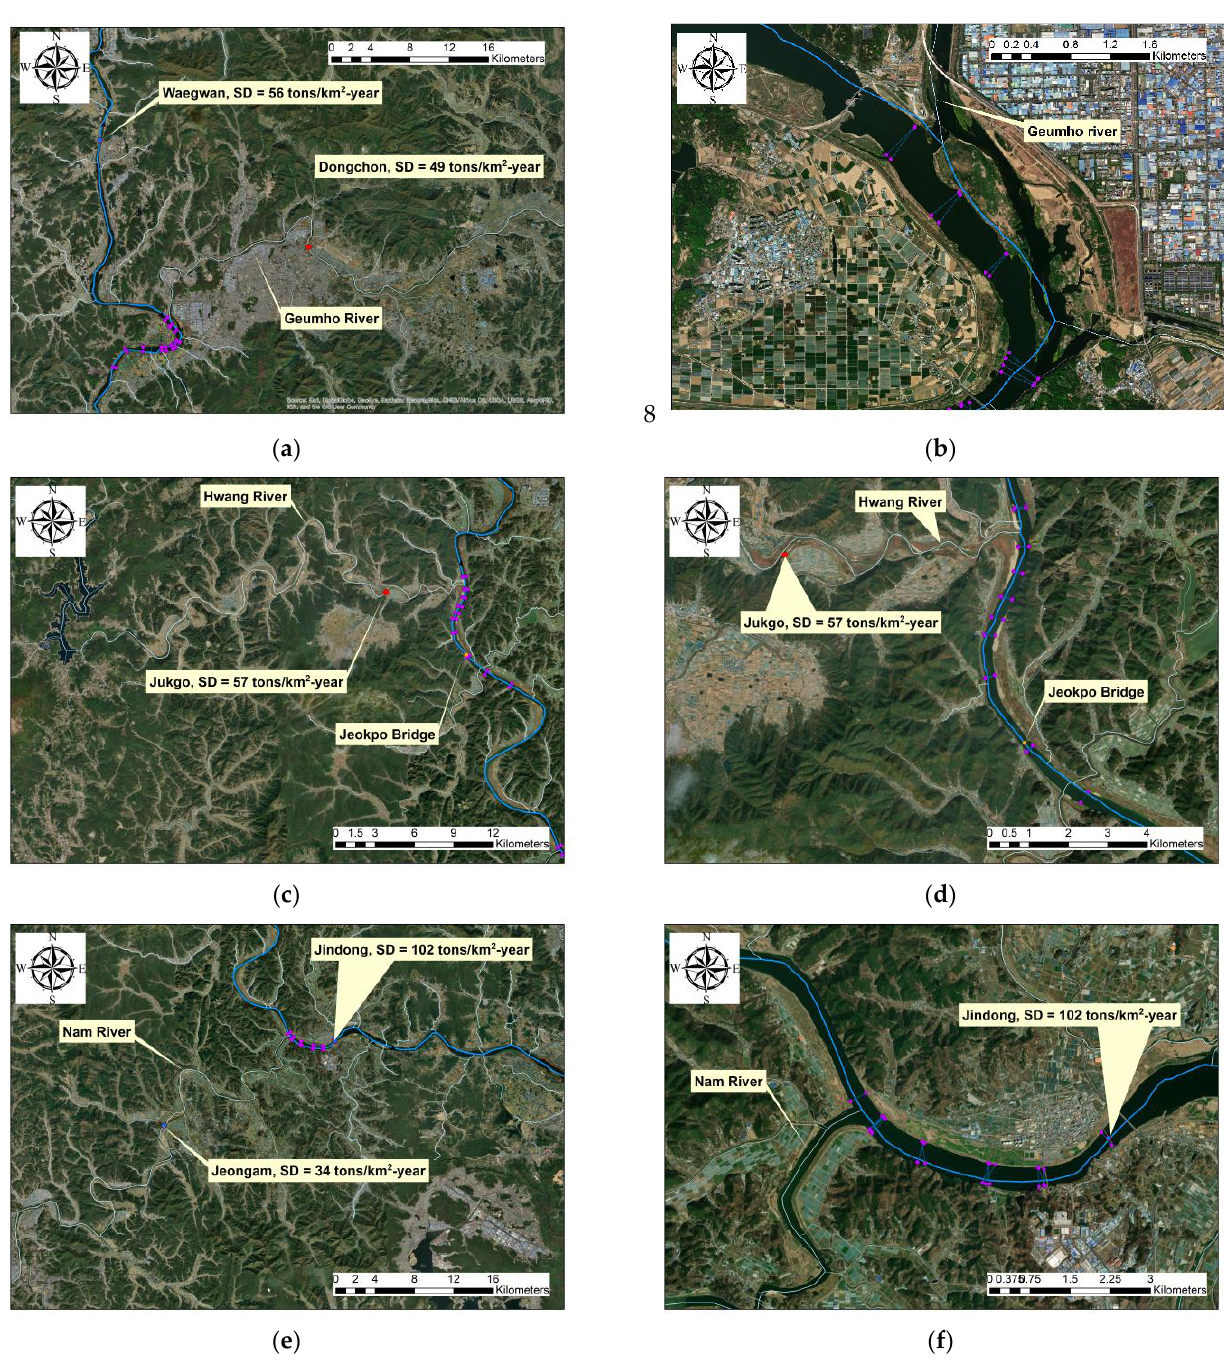
Figure 6. Measurement locations of validation data near the ( a , b ) Geumho, ( c , d ) Hwang, and ( e , f ) Nam River confluences.